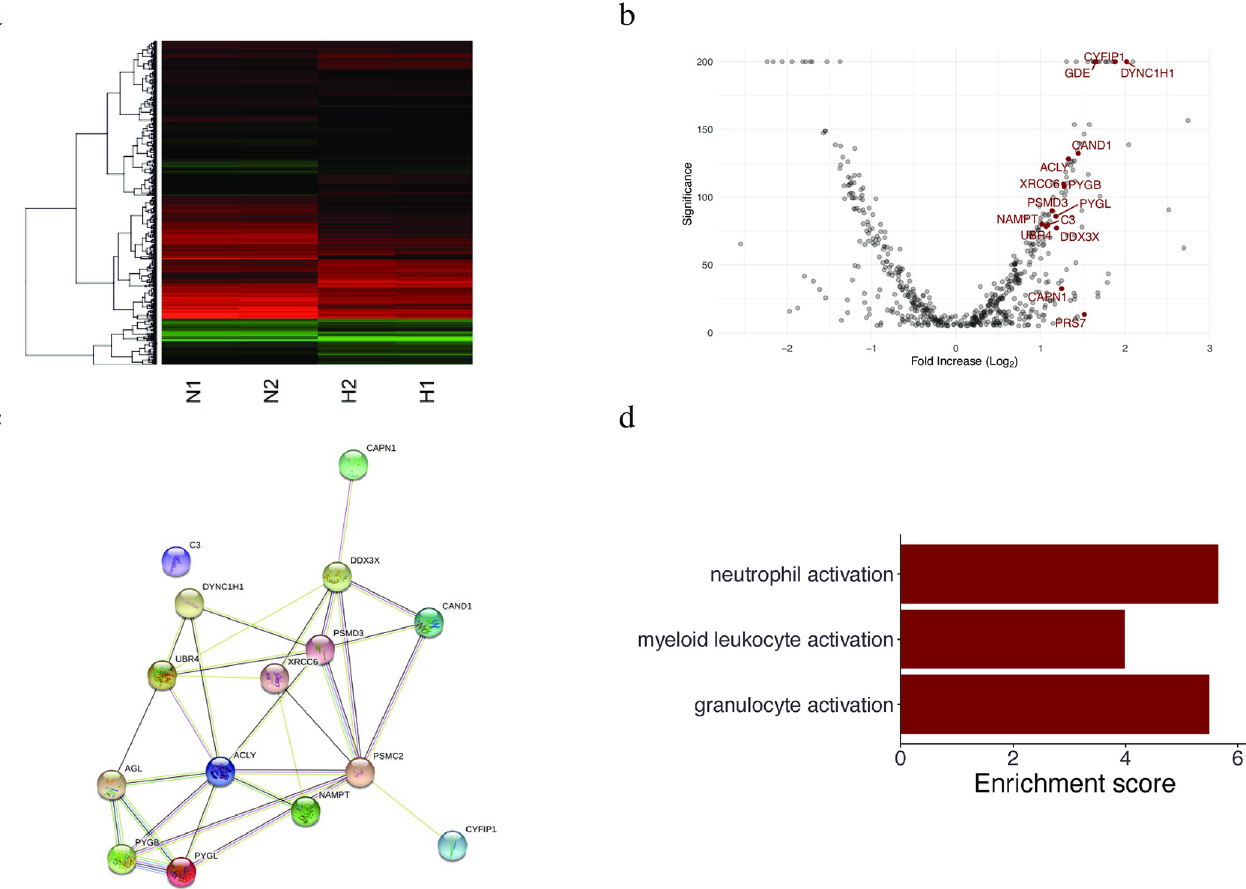
Fig 3. Proteomic analysis and GO term enrichment analysis of the isolated exosomes. The expression of proteins in the exosomes was quantified and compared between the normoxia and hypoxia groups using high-performance liquid chromatography-mass spectrometry. The proteins were analyzed using GO term enrichment analysis. (A) Heatmap showing protein expression in each group (N1, N2: normoxia; H1, H2: hypoxia). Red indicates high protein expression, whereas green indicates low expression. ( B ) Volcano plot showing the proteins analyzed using mass spectrometry. Red labels indicate proteins involved in inflammation. The description of each protein is given in S1 Table. (C) Results of protein network analysis conducted using the STRING v11.3 database. This figure was obtained using STRING v11.3 web-based software (https://string-db.org/). ( D ) Enrichment scores of GO analysis: biological processes. GO, Gene